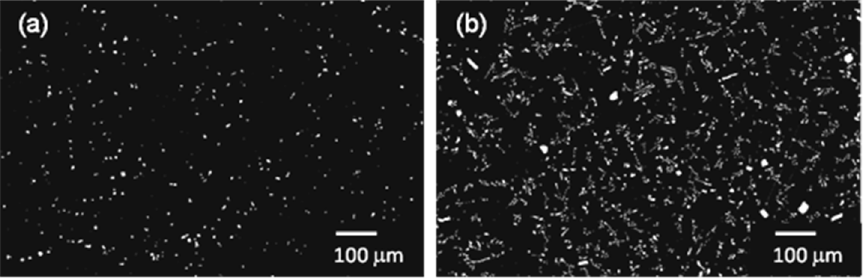
Figure 5. FESEM micrograph after 24 h aging: ( a ) Mg-4Al-1Nd alloy and ( b ) Mg-4Al-4Nd alloy.